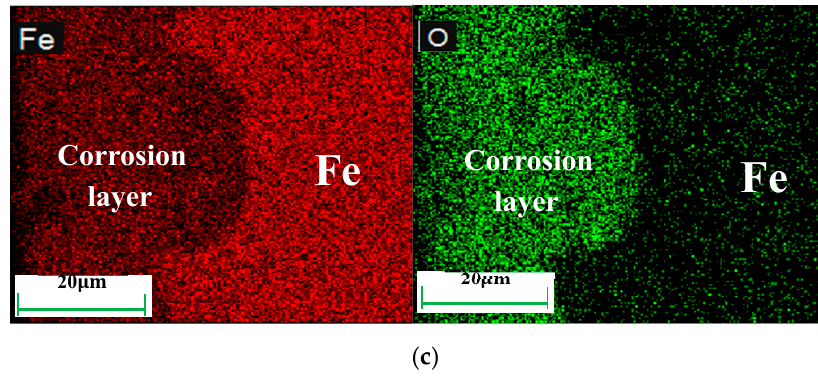
Figure 11. SEM and EDX observed the cross-section of the sample corroded for 8 h: ( a ) Cross-section SEM image; ( b ) analytical line; ( c ) corresponding X-ray maps of Fe and O.